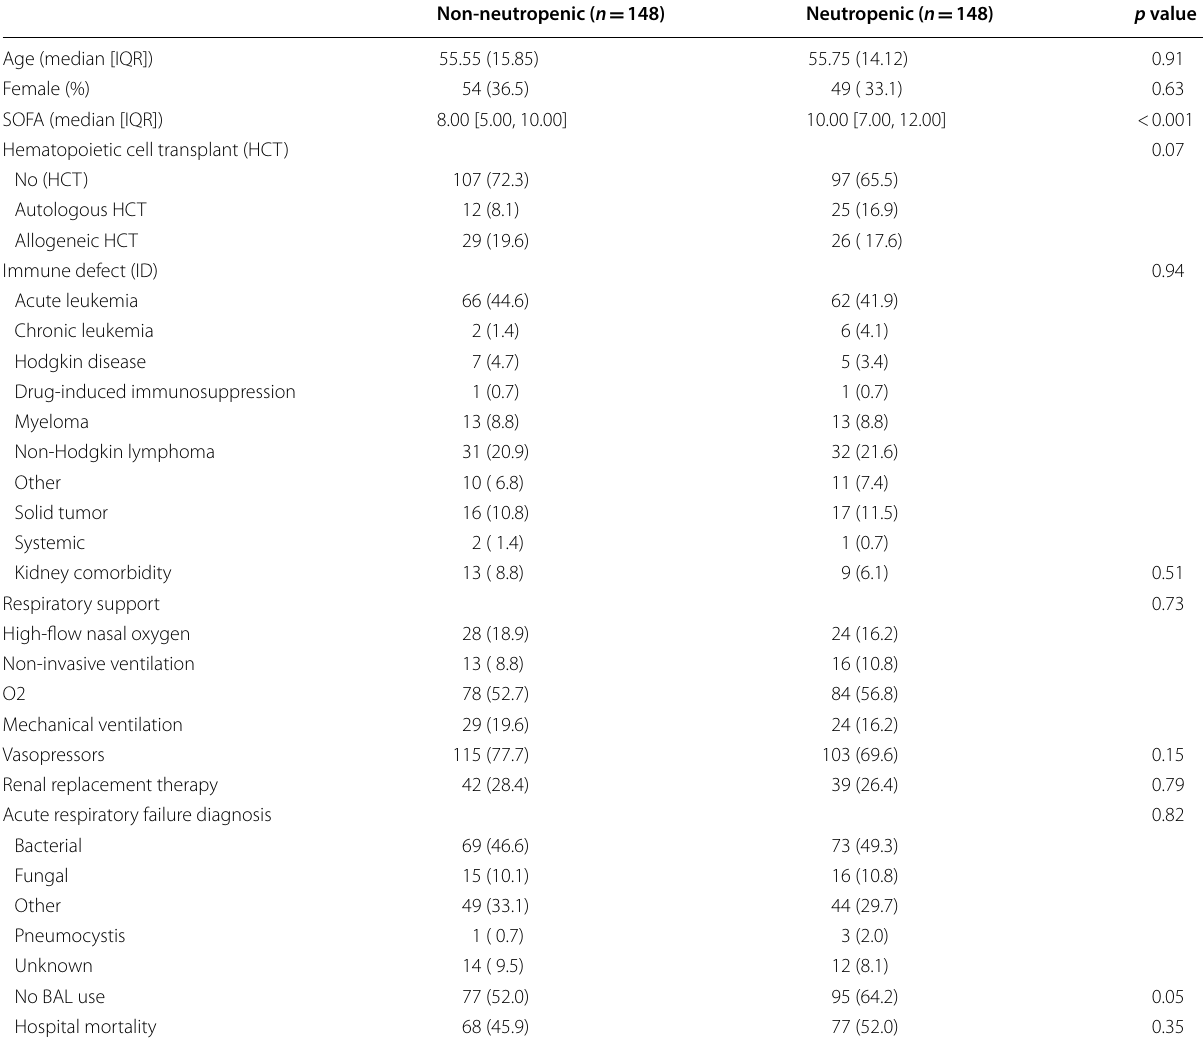
SOFA Sequential Organ Failure Assessment score, BAL bronchoalveolar